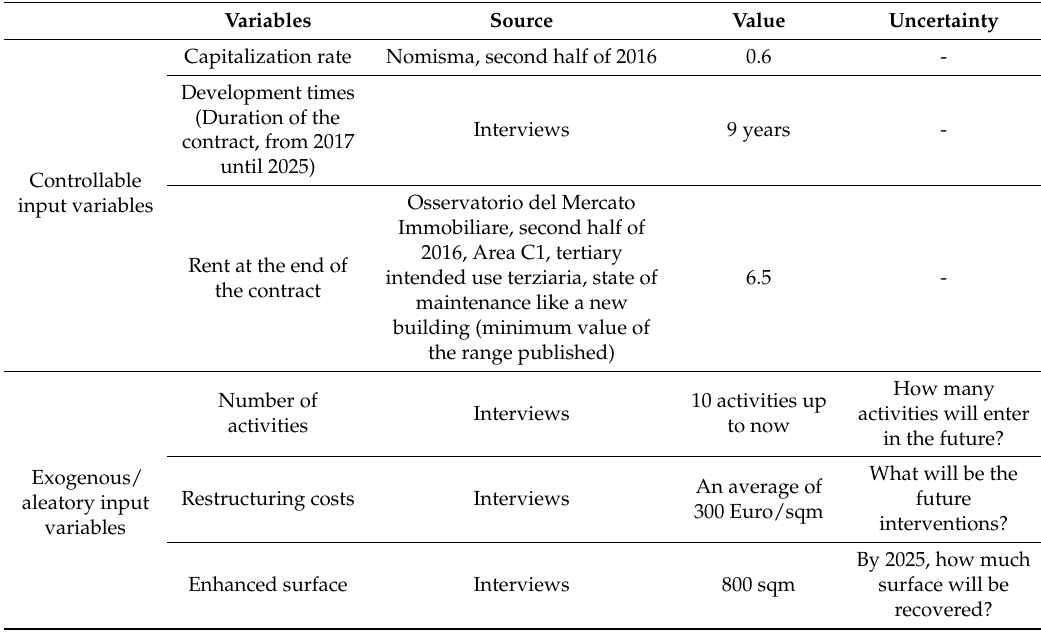
Table 1. Input variables to evaluate Factory Gris ù